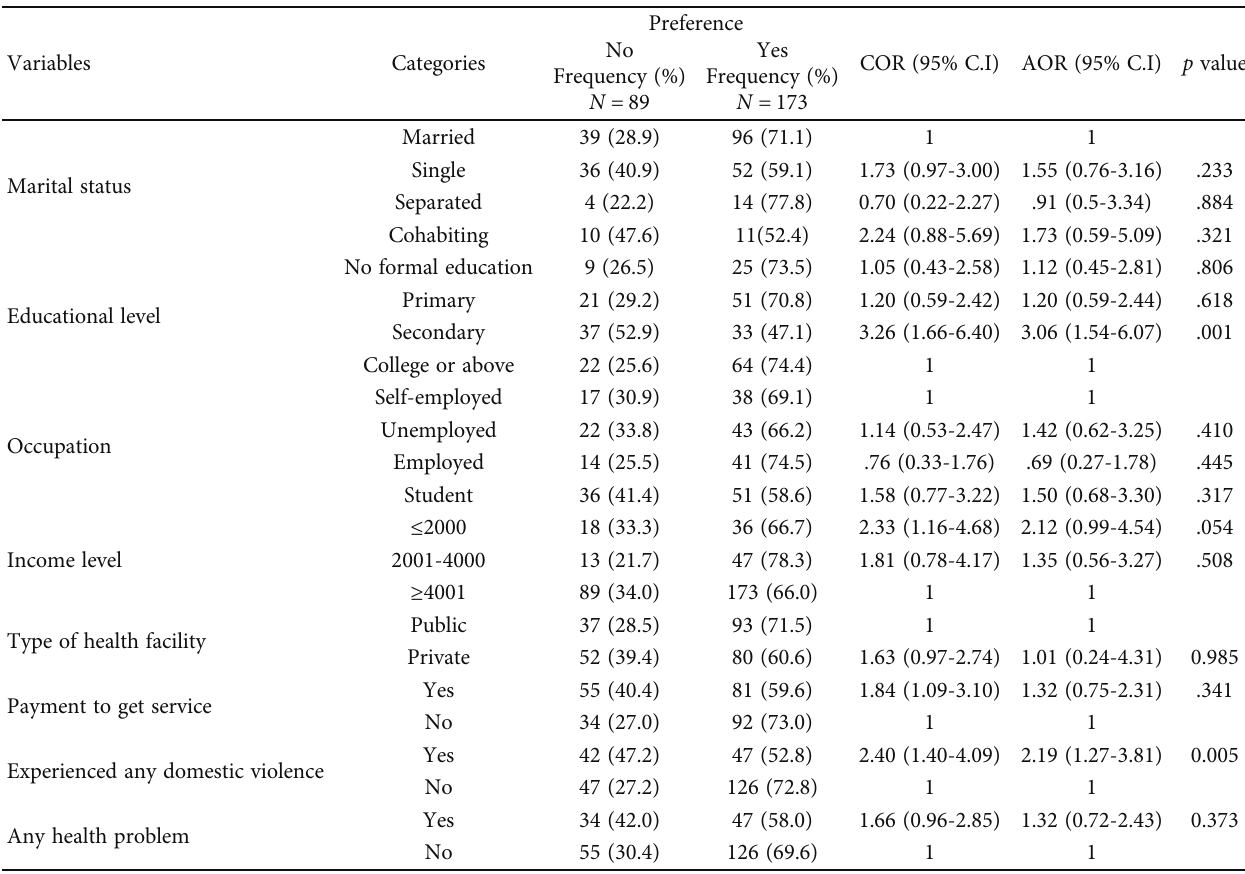
Table 4: Bivariate and multivariate logistic regression for the factors associated with postabortion contraceptive preference among women who received abortion care services at health facilities in Ambo town, Oromia region, Ethiopia,